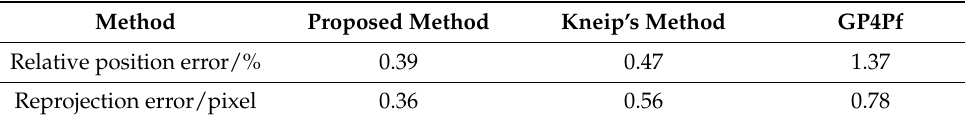
Table 2. Relative position error and reprojection error for real